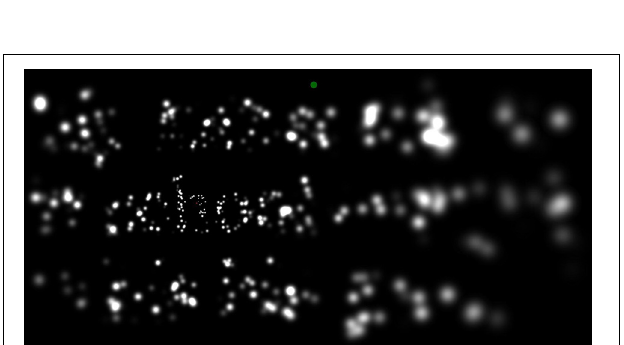
FIGURE 2 | A subject in front of the apparatus. A subject is shown seated in front of the Tobii TX300 gaze tracker, in a typical position for performing the experiment. No chin bar or other head stabilization is necessary with the TX300. The stimulus display screen in front of the subject shows a frame from the Reading Phase where a collection of phosphenes can be seen to very roughly depict three lines of large text. The bluish screen background and dark halos around the phosphenes are artifacts from the off-axis viewing angle of the camera; to the subject, the background appears uniformly black and the phosphenes as white Gaussians (see Figure 3 ).